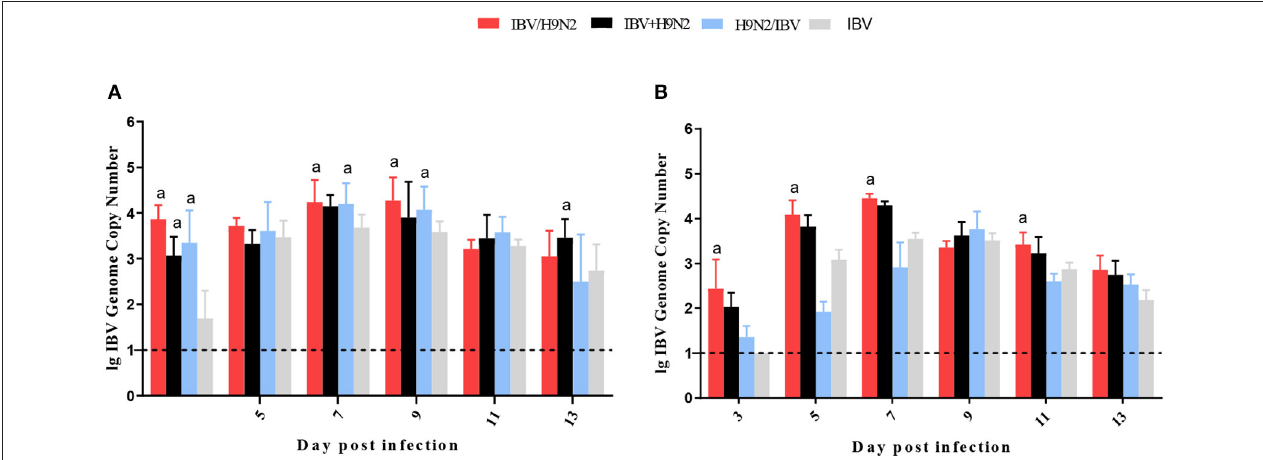
FIGURE 7 | Viral shedding of IBV. To investigate the viral shedding of IBV virus, oropharyngeal (A) and cloacal (B) swabs were collected for virus detection at 3, 5, 7, 9, 11, and 13 dpi using one-step RT-qPCR. Data are presented as means ± SD. “a” indicates a significant difference ( P < 0.05) between the three co-infection groups and the IBV group. Dashed black lines indicate the lower limit of detection. IBV, infectious bronchitis virus; RT-qPCR, quantitative reverse transcription polymerase chain reaction; SD, standard deviation.